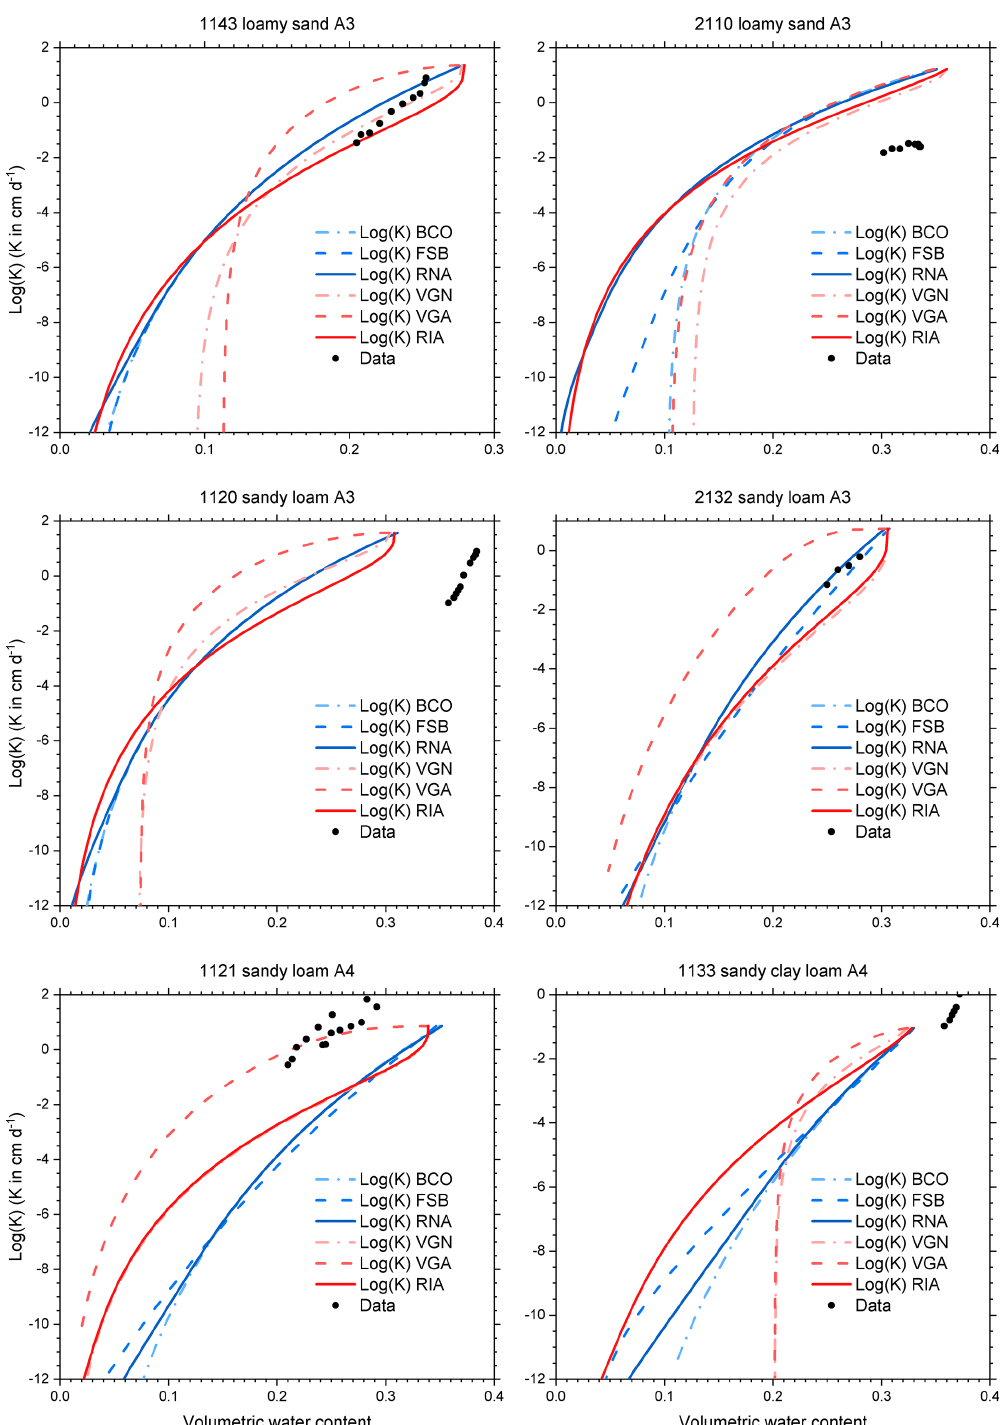
Figure C7. Conductivity data and conductivity curves derived from the retention curves of Fig. C3, according to six parameterizations for selected UNSODA soils with the A3 or A4 classification of Twarakavi et al. (2010)